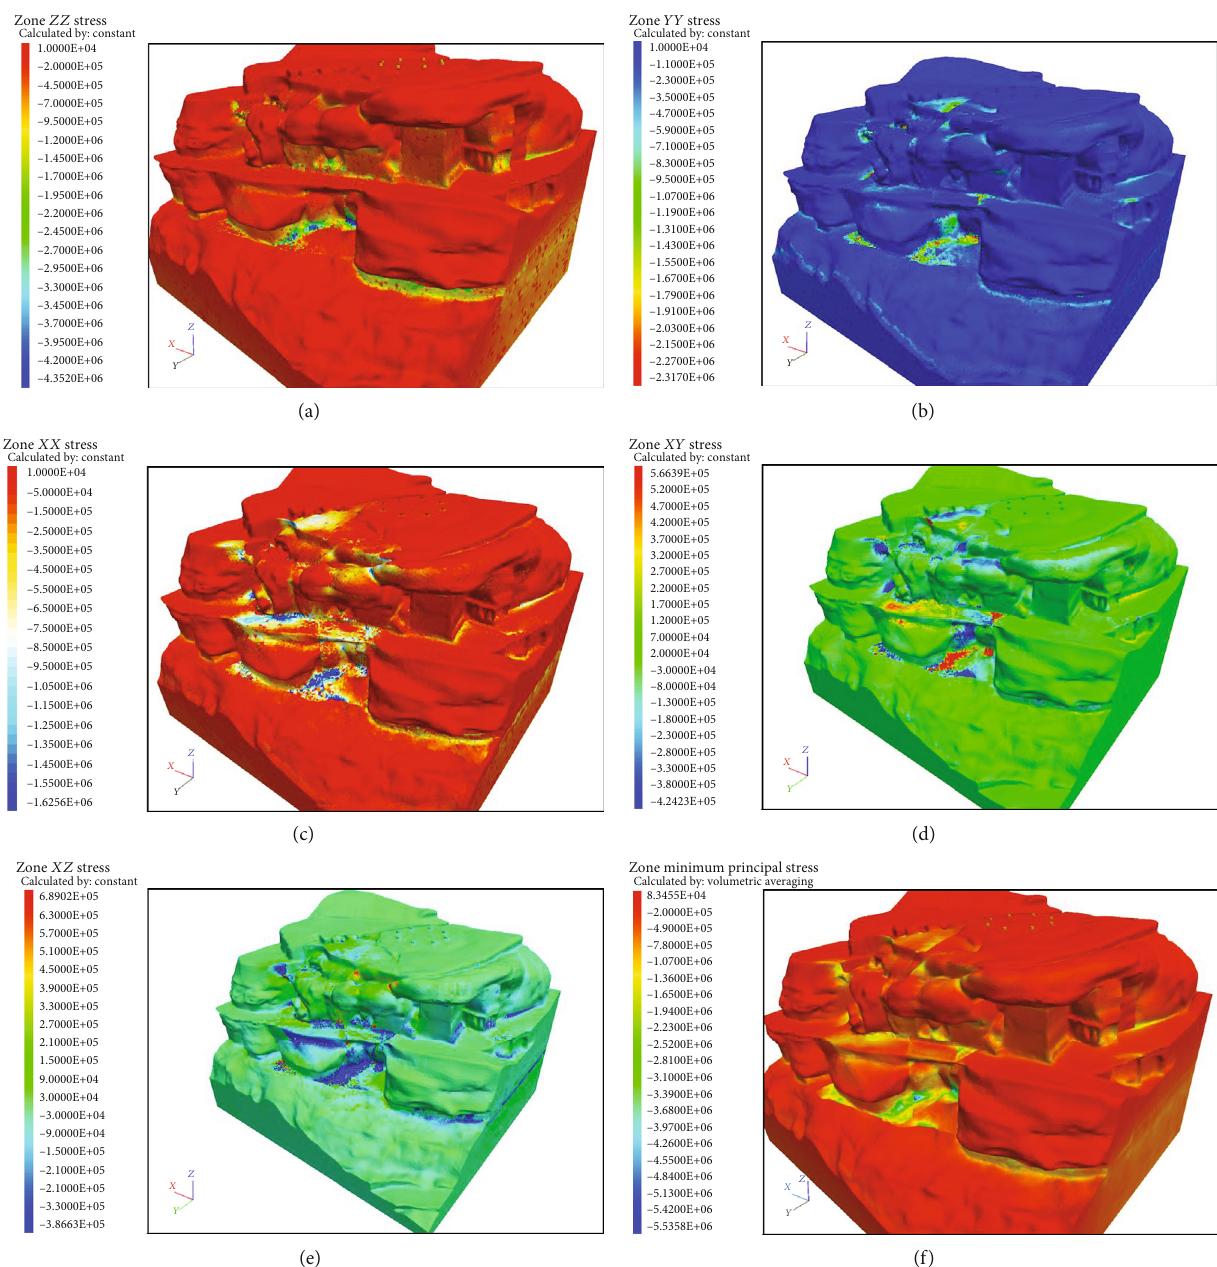
Figure 4: Stress nephogram contour of surrounding rock: (a) ZZ stress nephogram; (b) YY stress nephogram; (c) XX stress nephogram; (d) XY stress nephogram; (e) XZ stress nephogram; (f) maximum principal stress